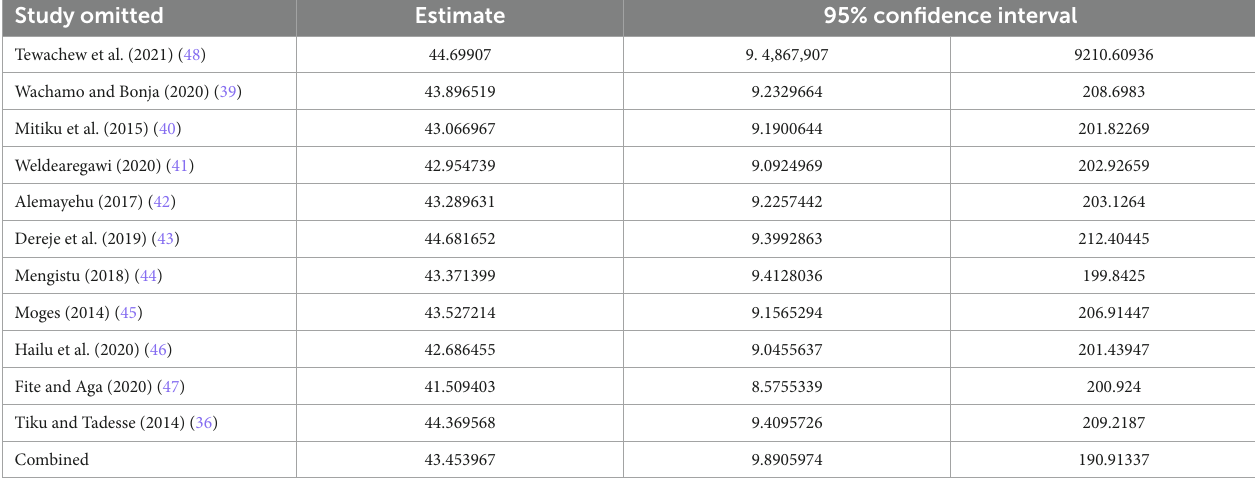
TABLE 3 Sensitivity analysis of pooled prevalence with each study removed one by one.